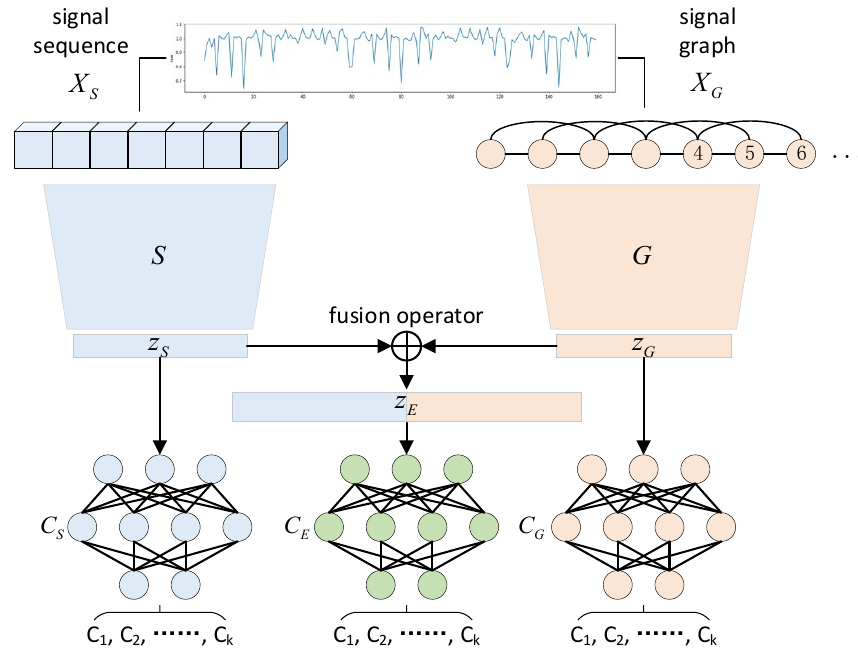
Figure 2. Structure of the ensemble neural network proposed in this